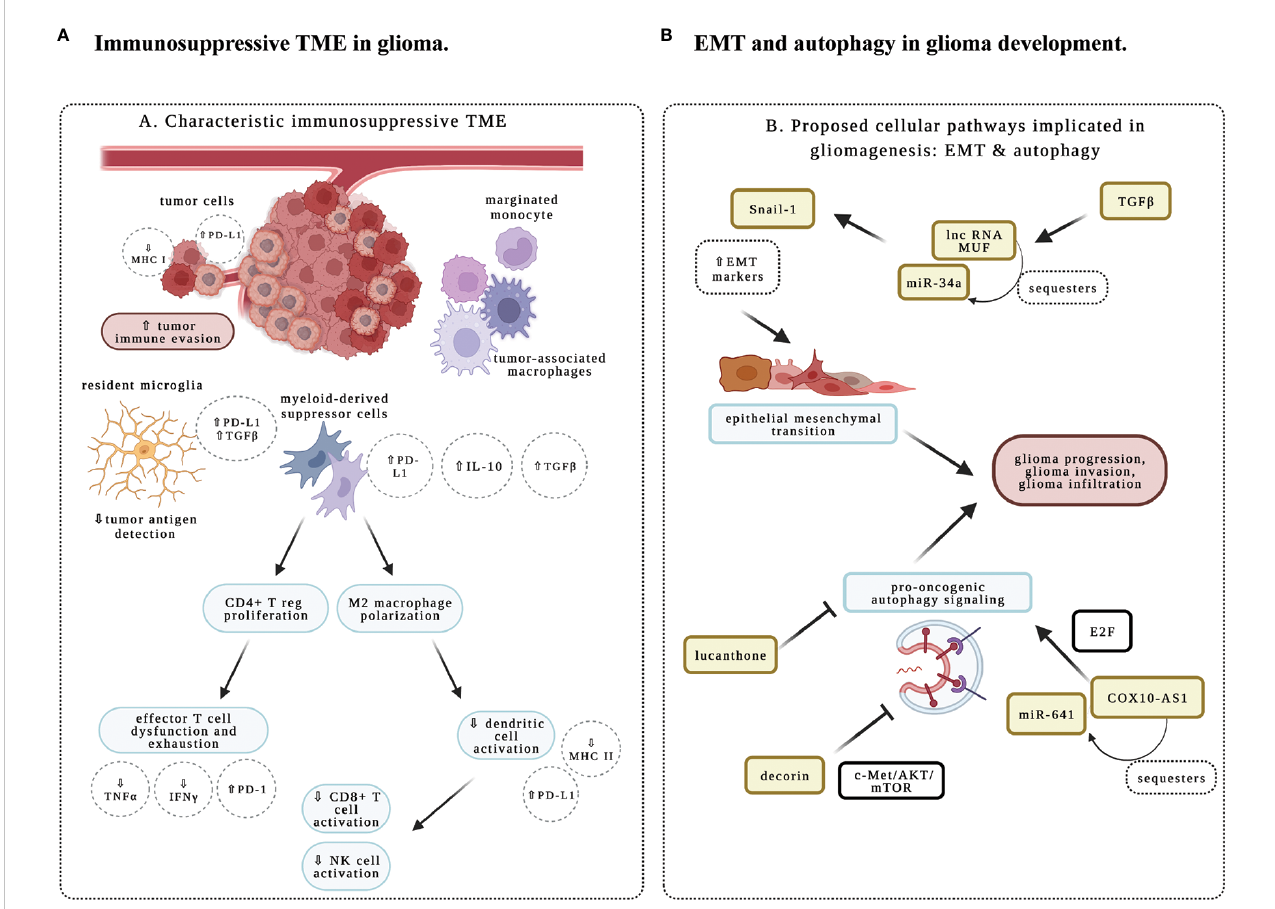
FIGURE 1 Schematic representation of immune and molecular regulation in glioma microenvironment. (A) Immunosuppression in glioma tumor microenvironment (TME). Immune responses are impacted by diverse cell types in the TME. Studies in the research topic highlight the importance of characterizing the immune phenotype in glioma. Tumor-associated macrophages (TAMs) include resident microglia, monocytes that will differentiate into M2- versus M1- predominant macrophages, and myeloid-derived suppressor cells (MDSCs), which are peripherally derived immunocytes that marginate through the blood-brain barrier. These cells are characteristic of an immunosuppressive TME and secrete key growth factors including interleukin 10 (IL-10) and transforming growth factor-beta (TGFß) to support an oncogenic niche. Cells of lymphoid origin, including T cells and natural killer (NK) cells; as well as other peripheral in fi ltrating cells, such as dendritic cells (DCs), are reported to be sparse within TME. MDSCs have been shown to prime CD4+ regulatory T cells (Treg) for an immunosuppressive and anergic role within gliomas. MDSC-primed Treg suppresses CD8+ effector T cell response, and contributes to effector T cell exhaustion through the downregulation of major histocompatibility complex class I molecules (MHC-I), suppression of signaling by interferon (IFN)- g and tumor necrosis factor (TNF)- a , and upregulation of programmed cell death ligand 1 (PD-L1). The M2-polarized macrophages typically downregulate the expression of MHC-II and PD-L1 to suppress the activation of CD8+ T cells, NK cells, and DCs in the TME, thereby contributing to the immunosuppressive properties of TME. (B) Epithelial to mesenchymal transition (EMT) and autophagy in glioma. Studies in this